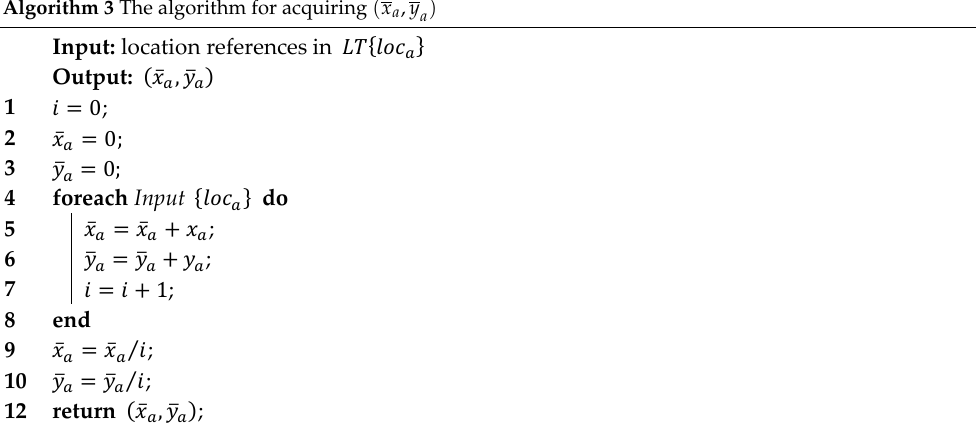
Algorithm 3 The algorithm for acquiring ( x a , y a )